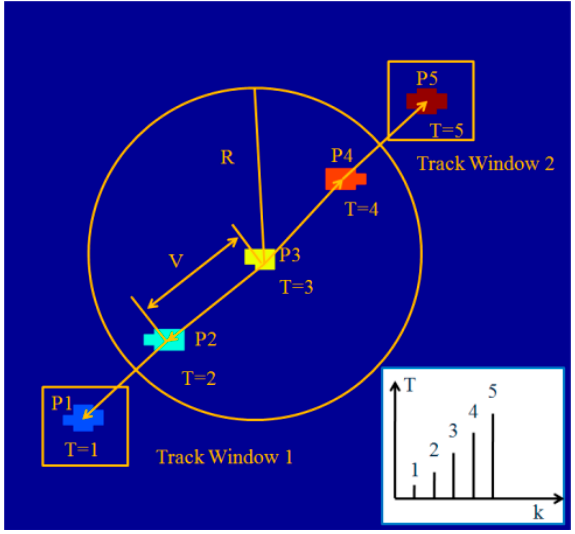
Figure 9. Target detection method based on time information.